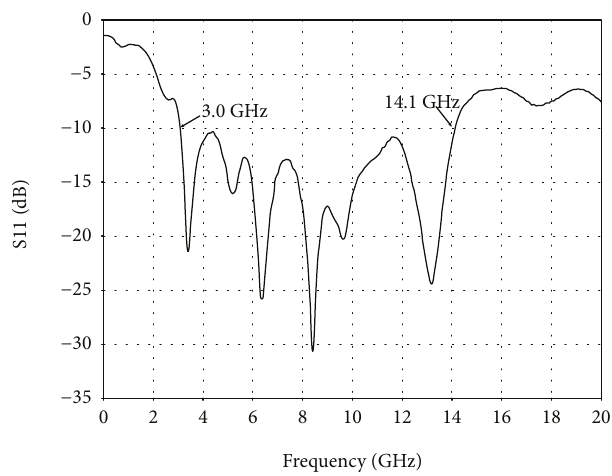
Figure 10: Measured S11 parameter of the proposed antenna.